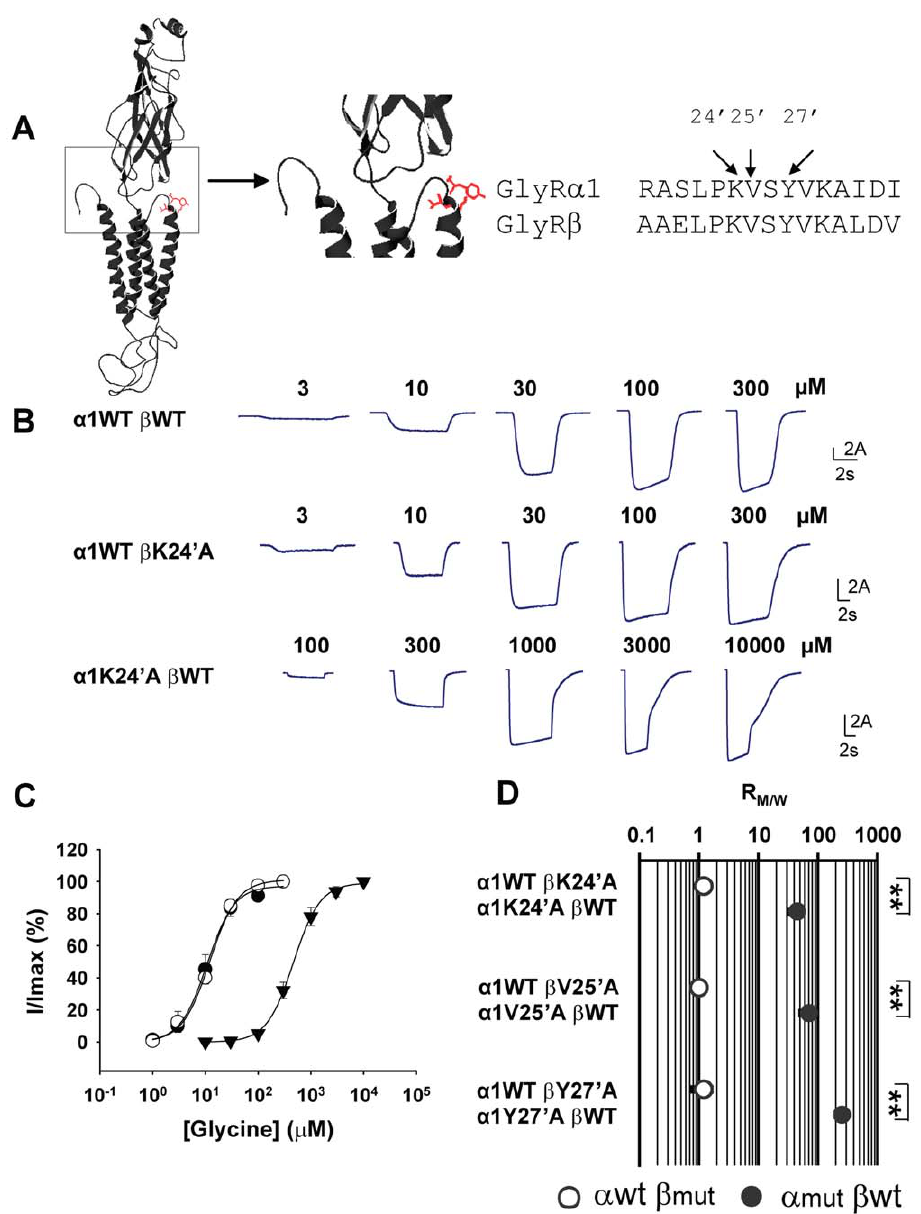
Figure 2. Effects of M2 – M3 loop mutations on a 1 b GlyR channel function. (A) The positions where mutations were introduced, K24 9 , V25 9 and Y27 9 , are shown in red in a structure model of the GlyR a 1 subunit (left panel). Their positions are also indicated in the amino acid sequences of N the M2–M3 loops of the a 1 and b subunits (right panel). (B) Example traces of currents induced by increasing glycine concentrations in the indicated ), a 1WT b K24 9 A GlyR ( # ) and the a 1K24 9 A b WT receptors. (C) Averaged normalized glycine concentration–response curves for the a 1WT b WT GlyR ( N GlyR ( . ). (D) The R M/W s (the EC 50 of the mutant a 1 b GlyR divided by the EC 50 of the WT a 1 b GlyR) resulting from introducing the K24 9 A, V25 9 A or ) and b ( # ) subunits are shown. ( ** p , 0.01 using the Student’s Y27 9 A mutation into the a 1 (